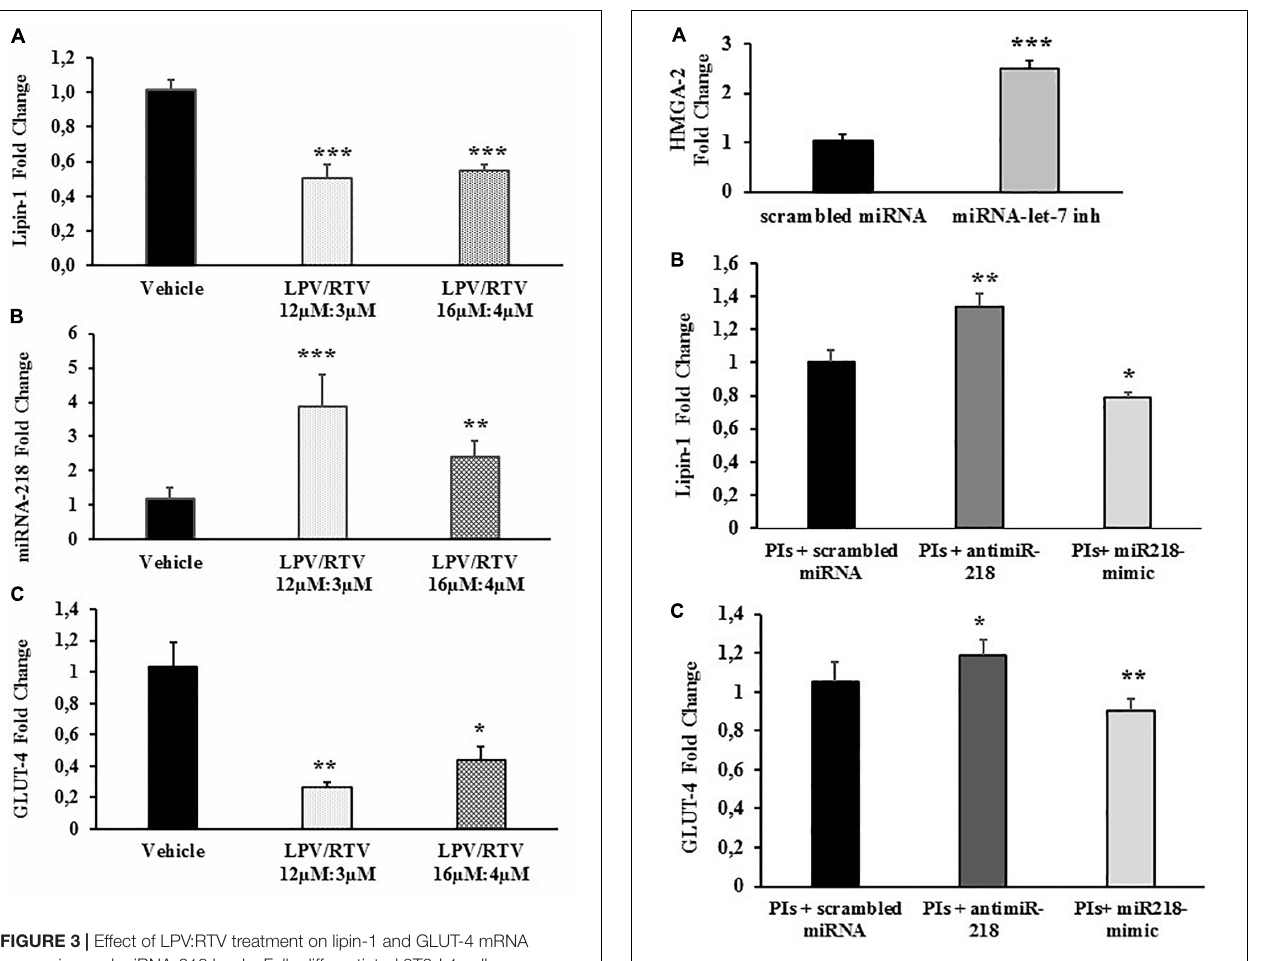
FIGURE 4 | miRNA-218 levels affect lipin-1 and GLUT-4 mRNA expression. Fully differentiated 3T3-L1 cells treated with LPV:RTV (12 µ M:3 µ M) (PIs) for 48 h or with vehicle alone, were transfected with: (A) scrambled miRNA or miRNA-let-7 inhibitor; (B,C) miRNA-218 inhibitor or miRNA-218 mimic or with scrambled miRNA. mRNA levels of HMGA-2 (A) lipin-1 (B) and GLUT-4 (C) were determined by real-time PCR 48 h after the transfection. Values are the mean ± SEM of at least 18 determination obtained in three independent experiments. ∗ p < 0.05, ∗∗ p < 0.01 and ∗∗∗ p < 0.001 vs. control (PIs + scrambled